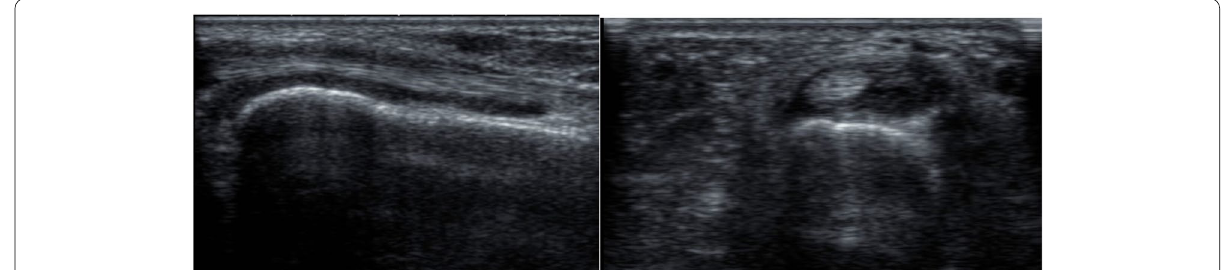
Fig. 1 GSUS dorsal longitudinal and transverse scan of wrist joint showing grade II tenosynovitis